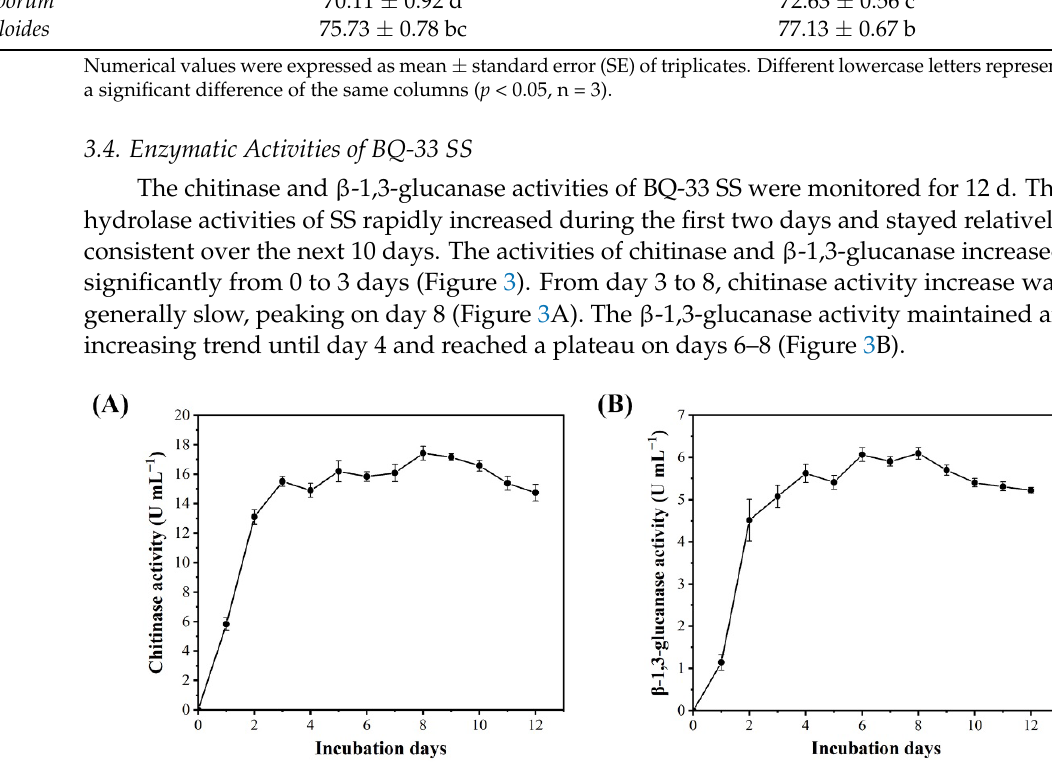
Figure 2. Inhibitory effect of BQ-33 suspension ( A ) and 200 mL L − 1 sterile supernatant (SS) ( B ) on fungal pathogens. (1) Didymella glomerata , (2) Botryosphaeria dothidea , (3) Alternaria alternata , (4) Fusarium oxysporum and (5) Phomopsis cauloides .